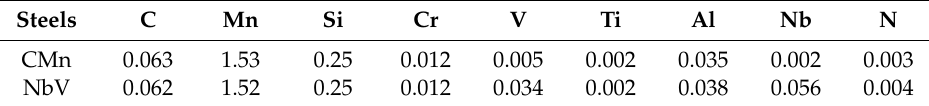
Table 1. Chemical composition of the studied steels (weight